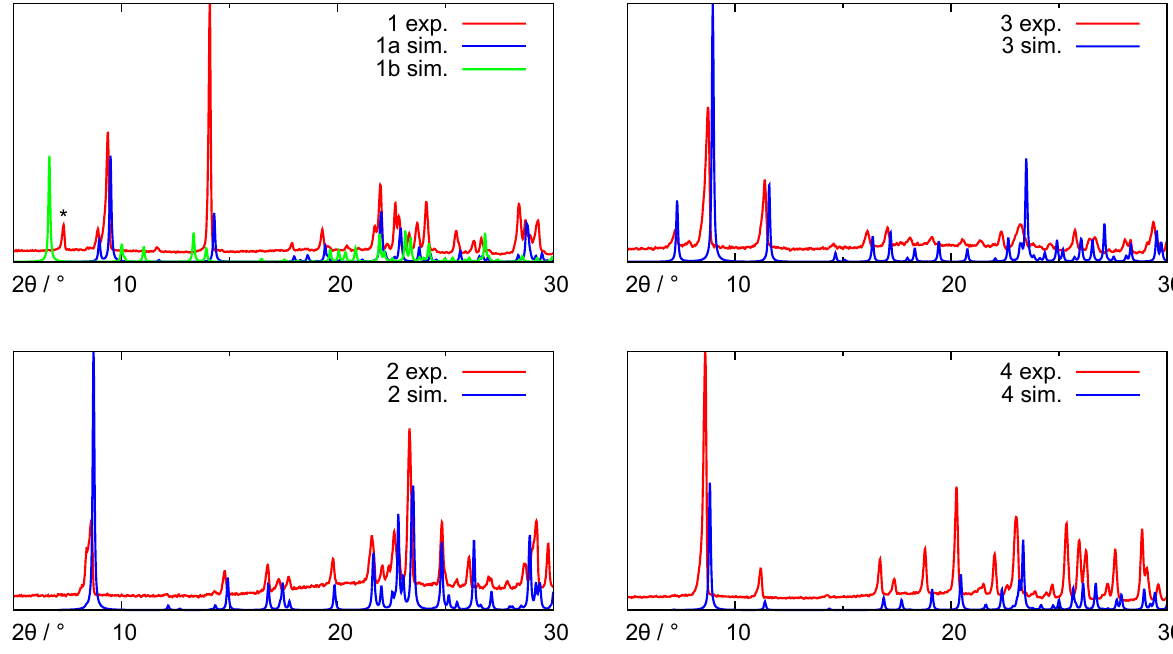
Figure 9. Simulated and experimental X-ray powder diffractograms of all products. Experimental data collected at room temperature. The asterisk indicates a reflection from unreacted